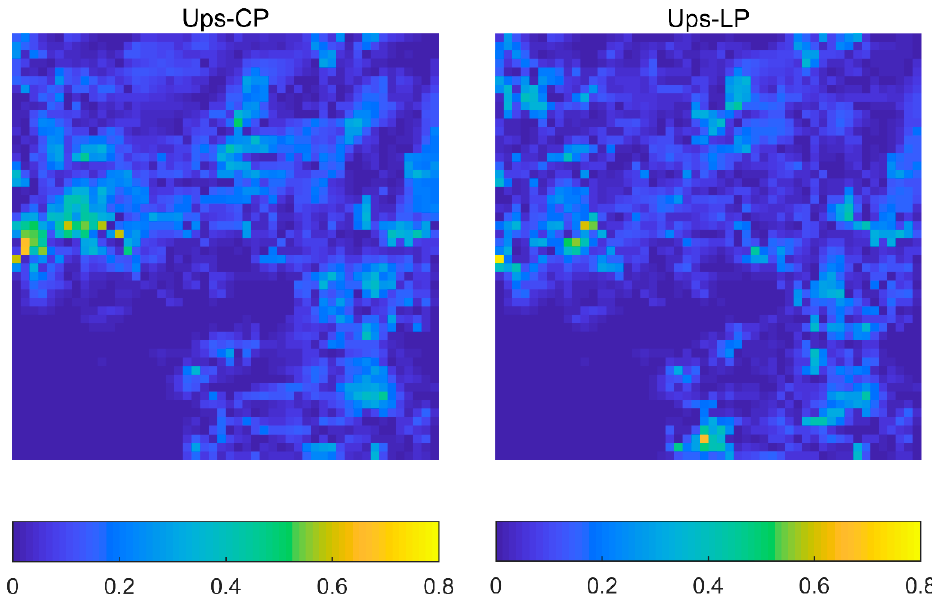
Figure 20. Case 3: absolute error of tracer concentration for Ups-CP ( left ) and Ups-LP ( right ). Energies 2020 , 13 , x FOR PEER REVIEW